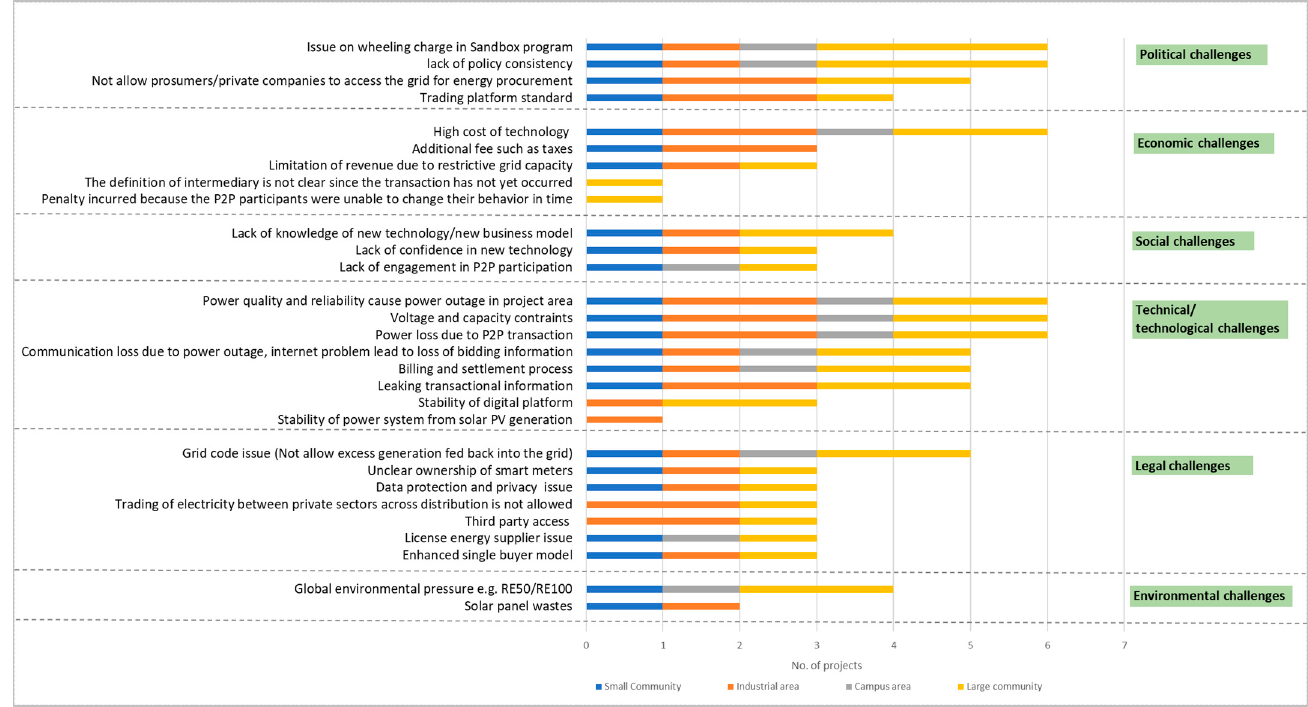
Figure 3. Perceived challenges of project developers to P2P energy trading project development under the PESTEL analysis. under the PESTEL